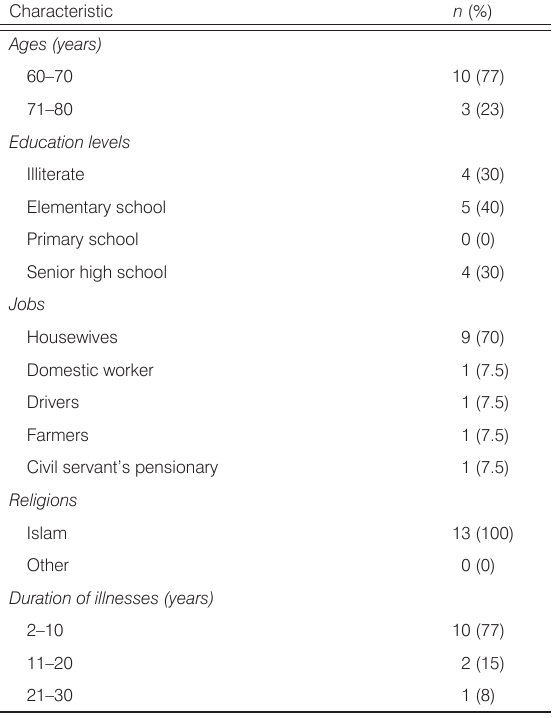
Table 1. Characteristics of